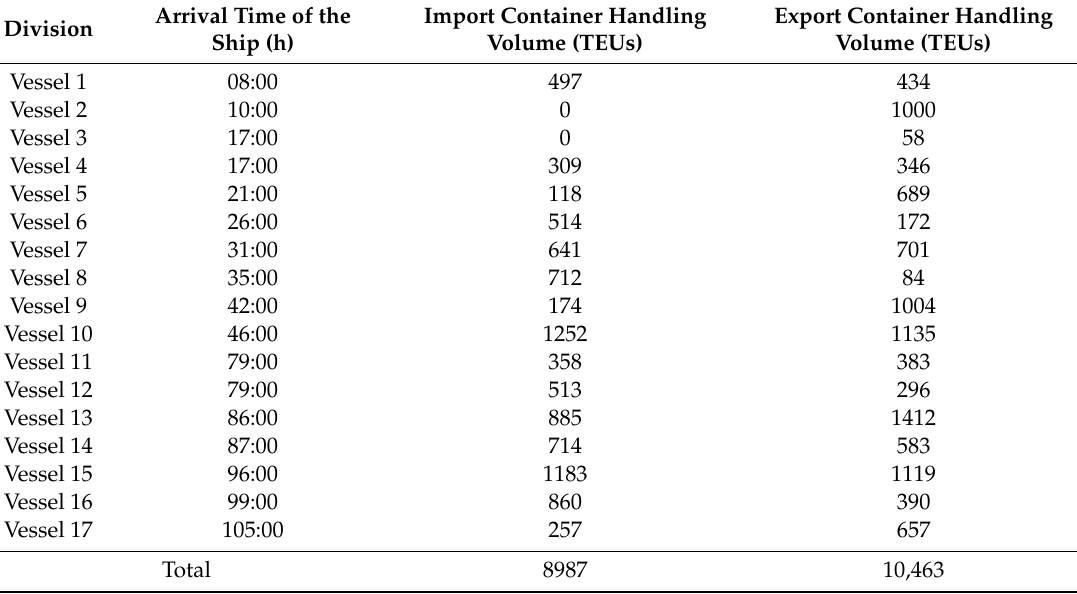
Table 2. Vessel schedule of the container terminal in the